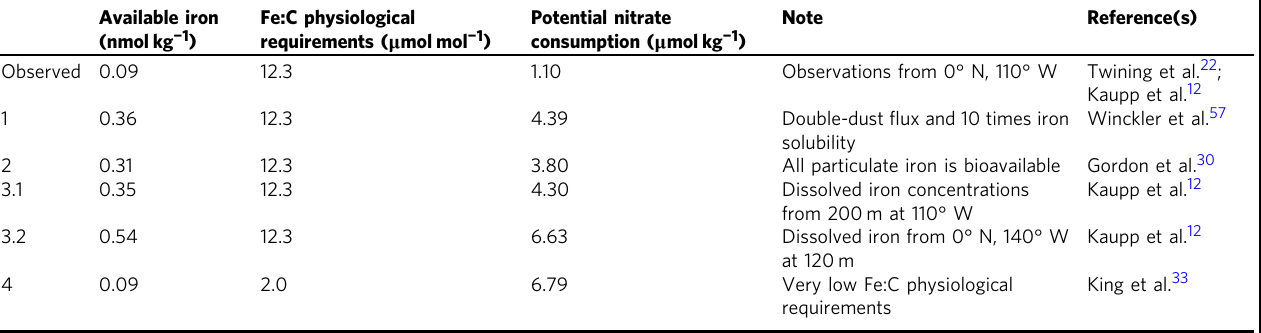
Table 2 Potential nitrate consumption was calculated for a range of iron concentrations and Fe:C physiological requirements Available iron (nmol kg − 1 )